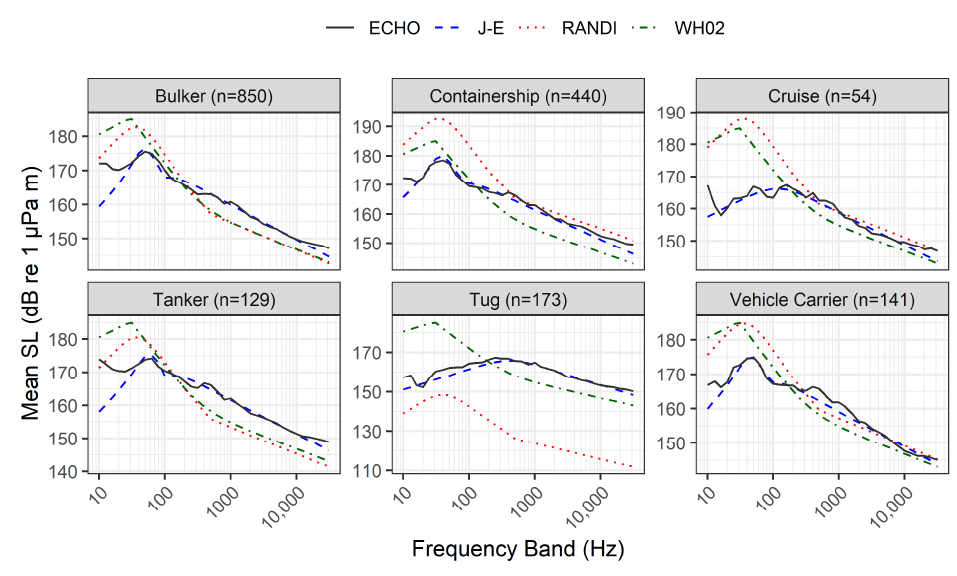
Figure 3. Comparison of the mean source level versus frequency predictions of the WH02, RANDI and JOMOPANS-ECHO (J-E) models with mean measured source levels from ECHO data set (black). The n value in each panel indicates the number of measurements that were averaged for the specified vessel type. Table 1. The vessel class ( C ) is obtained from the AIS ‘ship type’ parameter, according to the fol- lowing table, which also presents the reference speed ( 𝑉 (cid:3004) ) per vessel class, the number of unique vessels, the number of measurements ( n ), and the mean length ( 𝑙 ) per vessel type of the measured ships in the ECHO data set and the dredgers from [22] used for the present model development. Many vessels in the data set were measured more than once.